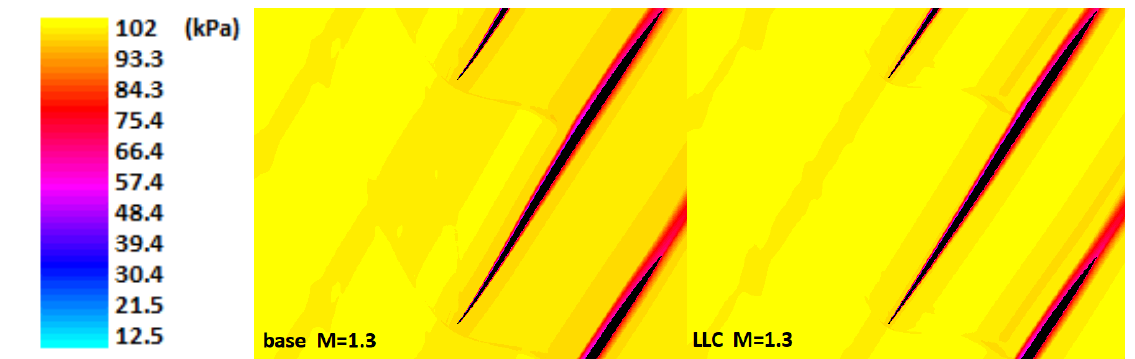
Figure 13. Mach contours of optimized profile at Mach 1.58.